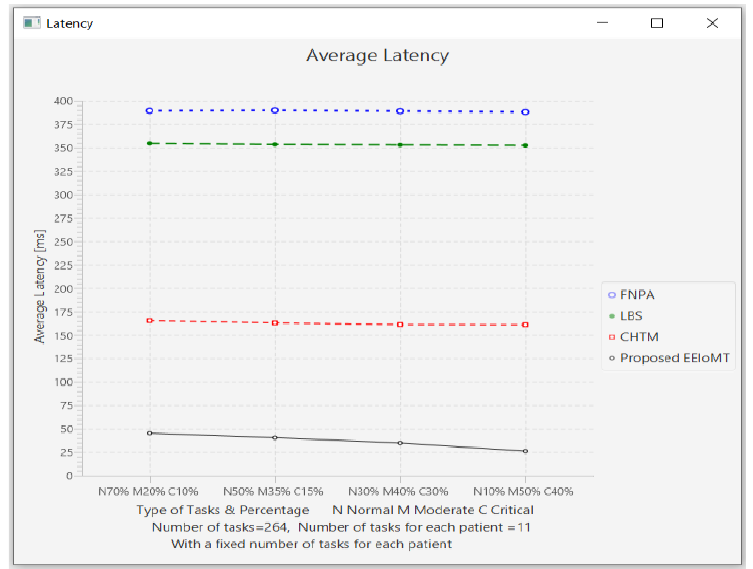
Figure 24. Average latency comparison when changing the percentage of each type of task.